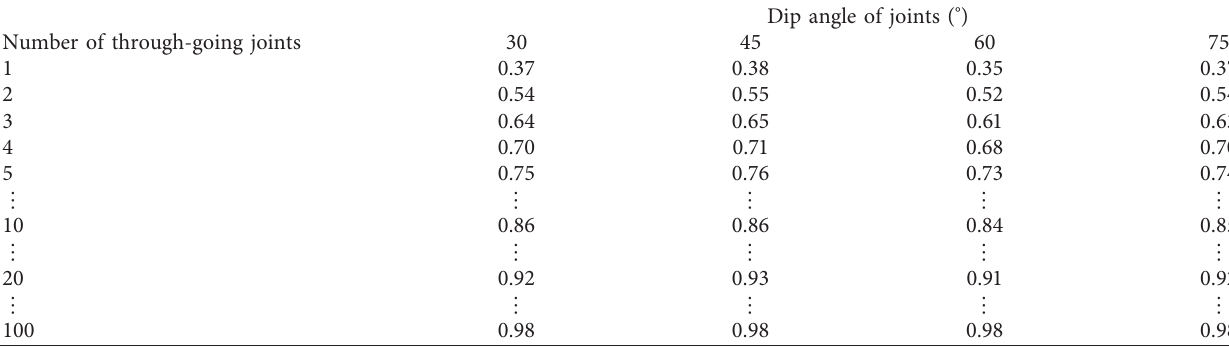
Dip angle of joints ( ° )